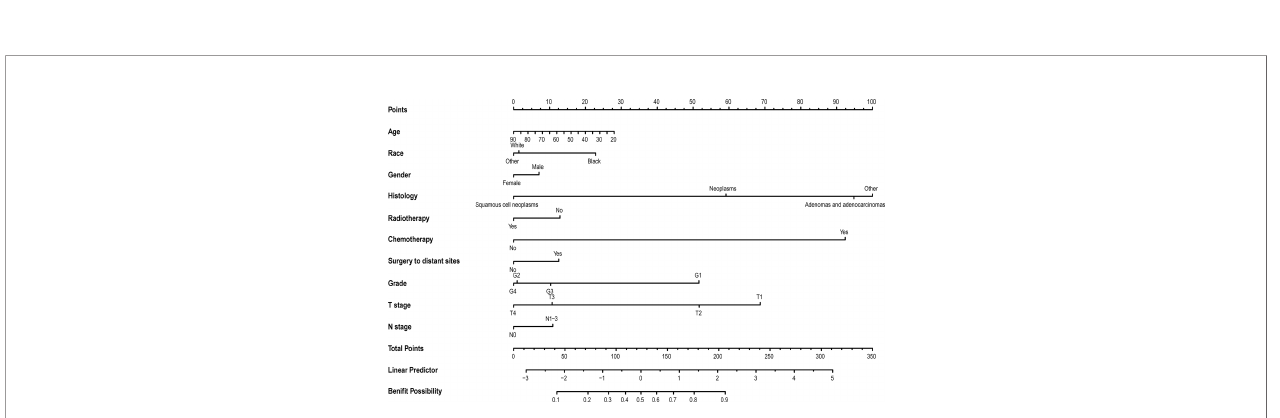
Frontiers in Oncology |